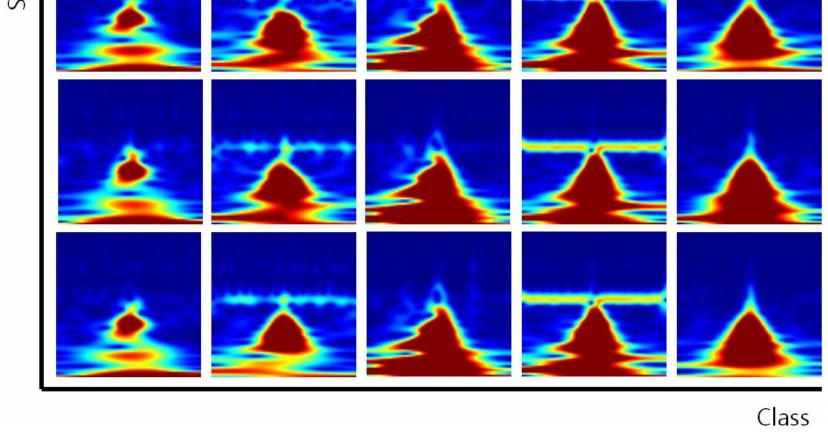
Figure 8. Scalograms of PTB-ECG.